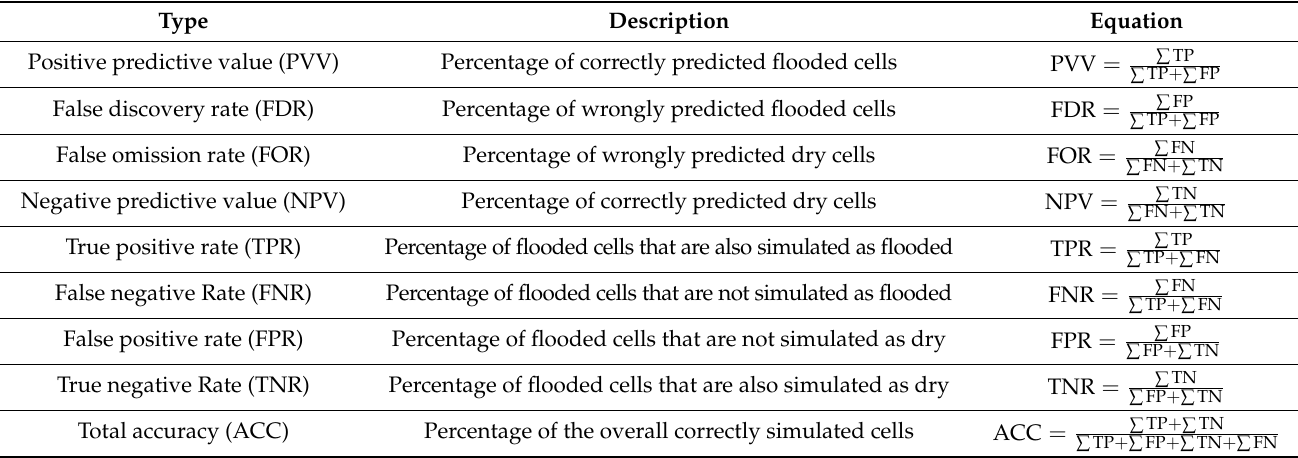
Table 2. Determined terms by means of the confusion matrix.